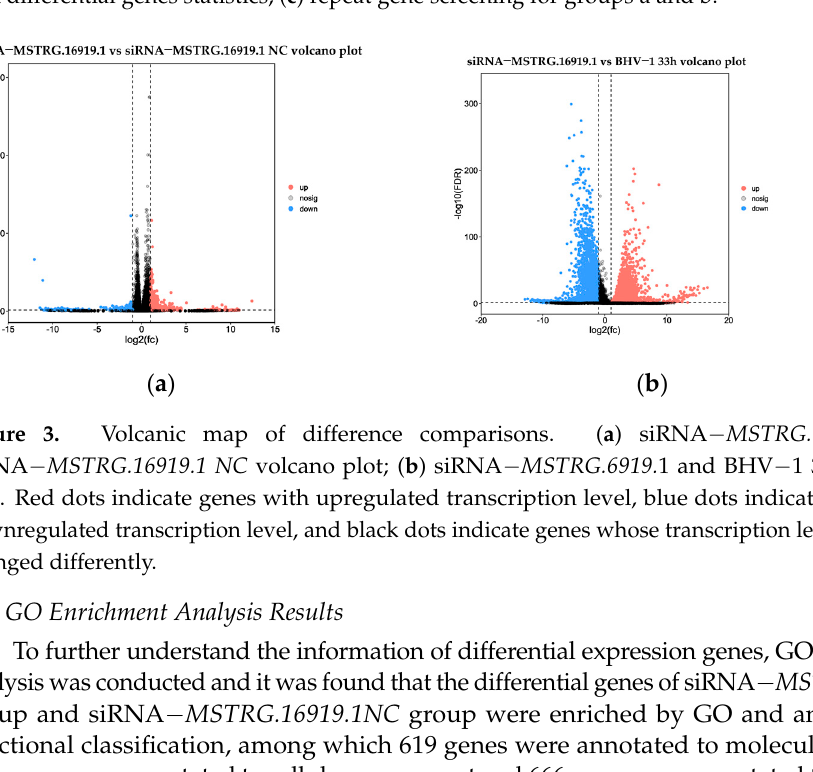
Figure 3. Volcanic map of difference comparisons. ( a ) siRNA − MSTRG.16919.1 and siRNA − MSTRG.16919.1 NC volcano plot; ( b ) siRNA − MSTRG.6919. 1 and BHV − 1 33 h volcano plot. Red dots indicate genes with upregulated transcription level, blue dots indicate genes with down- regulated transcription level, and black dots indicate genes whose transcription levels have not changed differently.